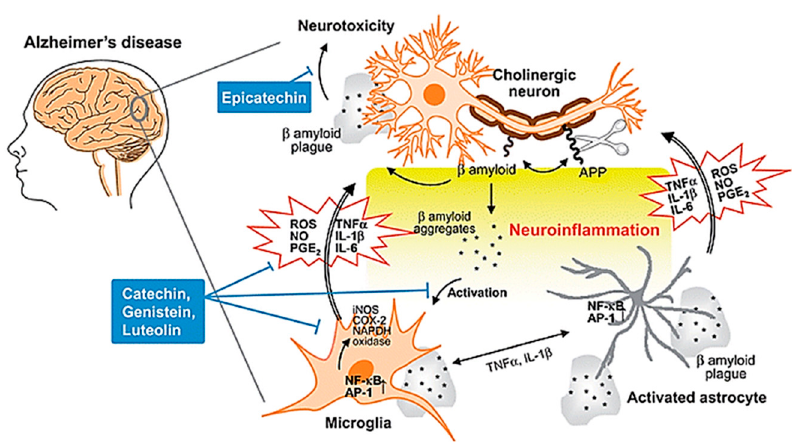
Figure 3. Neuroinflammation in AD. During the development of AD, A β peptide is produced by cleavage of APP, aggregates and accumulates as β amyloid plaques. Both aggregates and plaques cause neurotoxicity or activation of microglia through up-regulating NF- κ B and AP-1 transcription factors, which in turn release ROS and pro-inflammatory cytokines such as NO, PGE2, IL-1, IL-6, and TNF-a that damage cholinergic neuron. These pro-inflammatory cytokines also directly activate astrocytes that also produce cytokines to amplify inflammatory signals and result in neuroinflammation and neurodegeneration. Flavonoids act through avoiding β amyloid induced-neuron injury and death, modulation of pro-inflammatory cytokines and ROS production, as well as inhibiting the activation of microglia and astrocyte as neuroprotective mechanisms. Abbreviations: AD: Alzheimer’s disease; APP: amyloid precursor protein; A β : amyloid beta; NF- κ B: nuclear factor kappa B; AP-1: activator protein 1; ROS: reactive oxygen species; NO: nitric oxide; PGE2: prostaglandin E2; IL-1: interleukin-1; IL-6: interleukin-6; TNF- α : tumor necrosis factor alpha. Reproduced from [30], with permission from Royal Society of Chemistry, 2010.